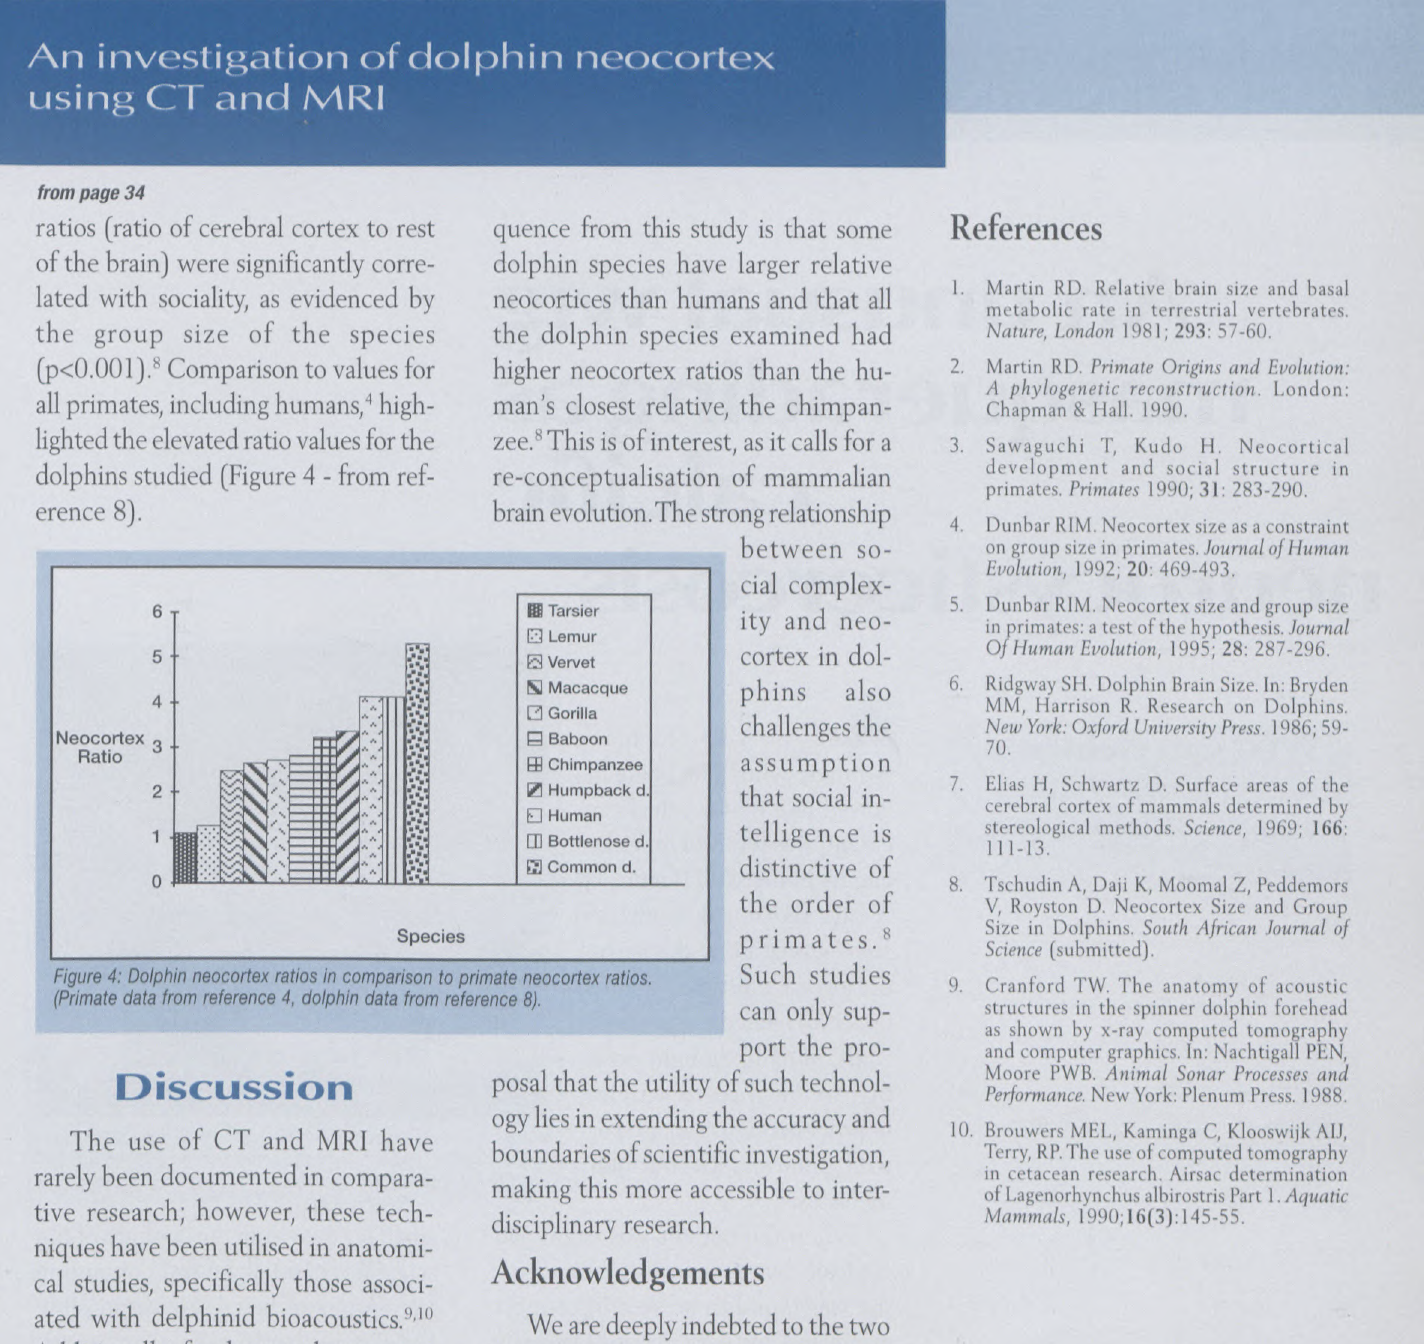
Figure 4: Dolphin neocortex ratios in comparison to primate neocortex ratios. (Primate data from reference 4, dolphin data from reference